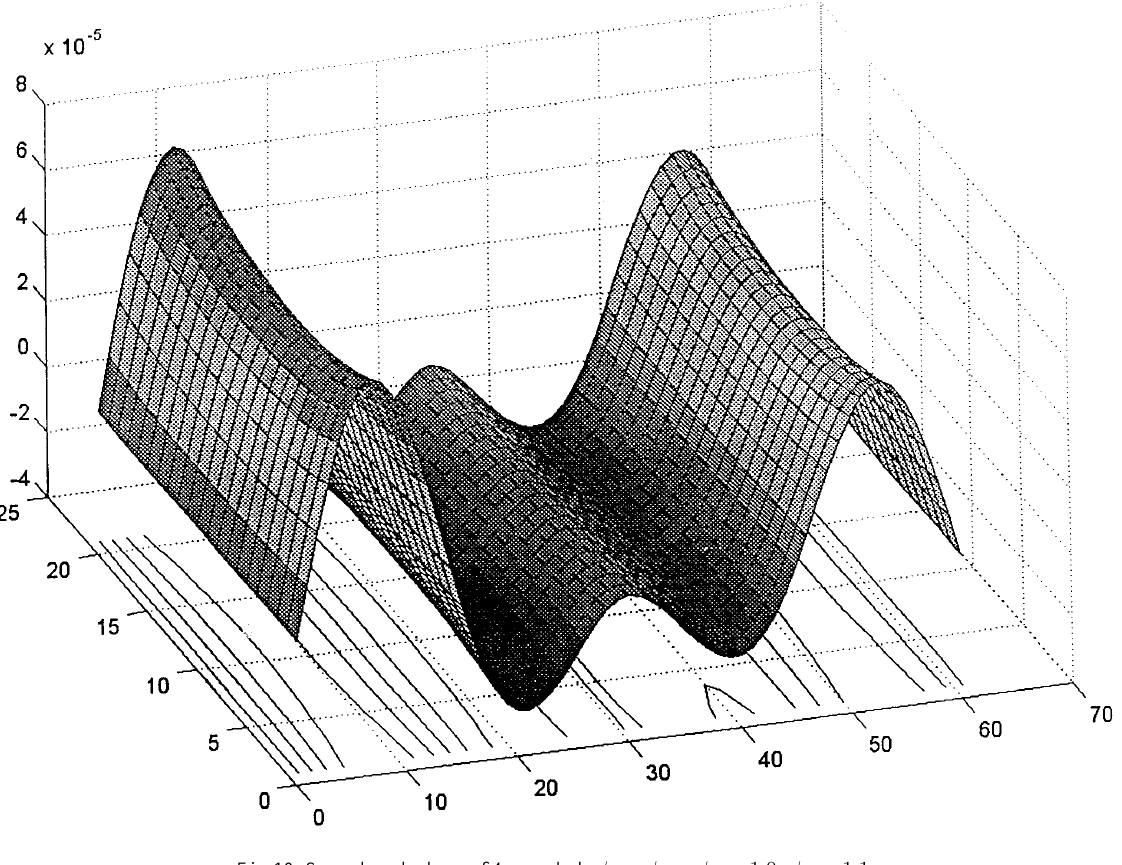
Fig. 10. Second mode shape of 4-span deck, φ 1 = φ 3 = φ 4 = 1 . 0 , φ 2 = 1 . 1 .